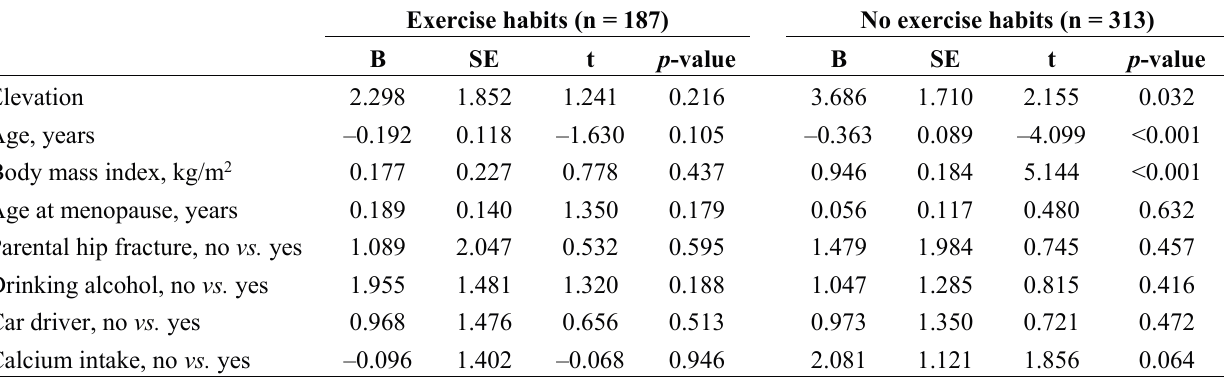
Table 3. Multivariable linear regression analysis among women. Exercise habits (n =